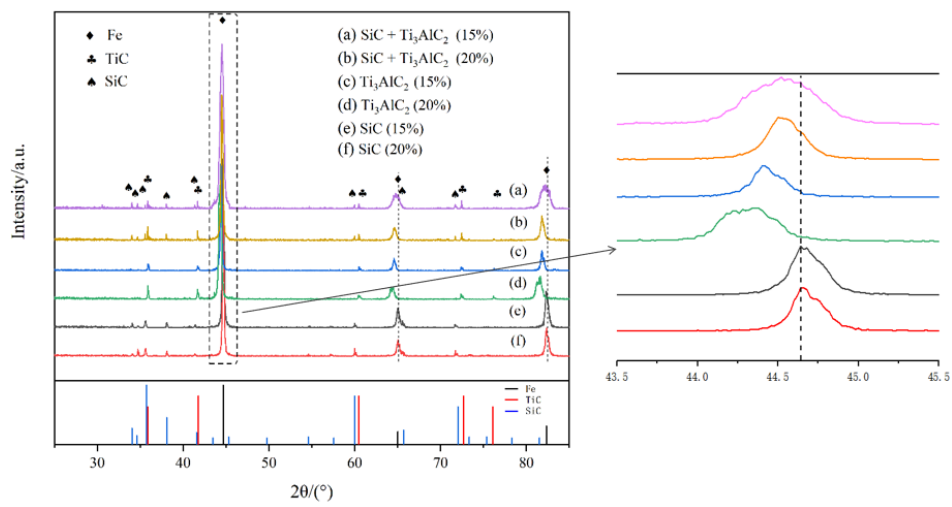
Figure 3. XRD patterns of the as-prepared samples supplemented with ( a ) 15% (SiC + Ti 3 AlC 2 ), ( b ) 20% (SiC + Ti 3 AlC 2 ), ( c ) 15% Ti 3 AlC 2 , ( d ) 20% Ti 3 AlC 2 , ( e ) 15% SiC, and ( f ) 20% SiC.